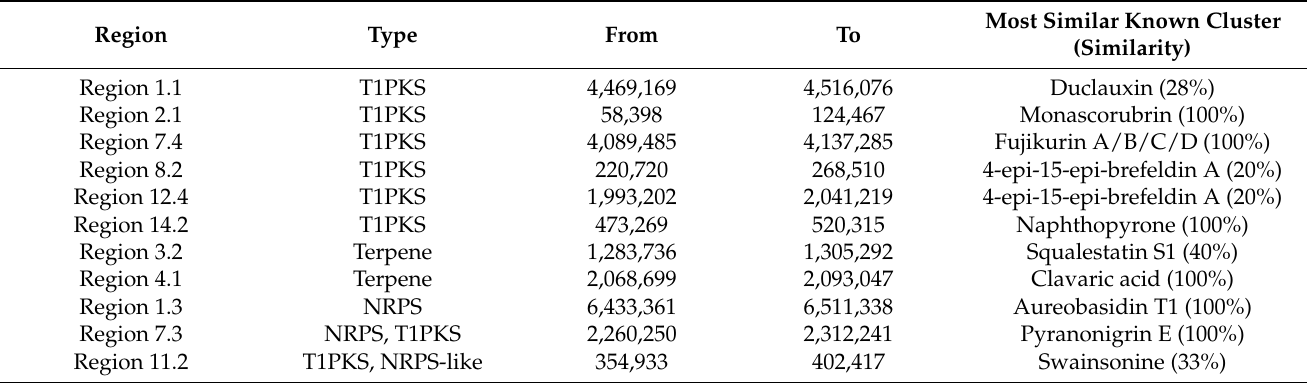
Table 2. Putative biosynthetic gene clusters (BGCs) of D. alcacerensis CT-6 showed similarity to known gene clusters in the MIBiG